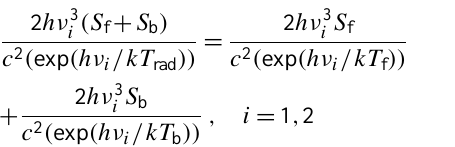
for the learning for the learning p p